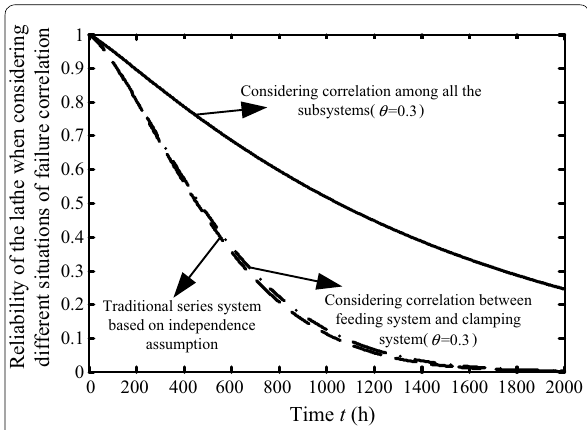
Figure 4 Reliability curves when considering different situations of failure correlation